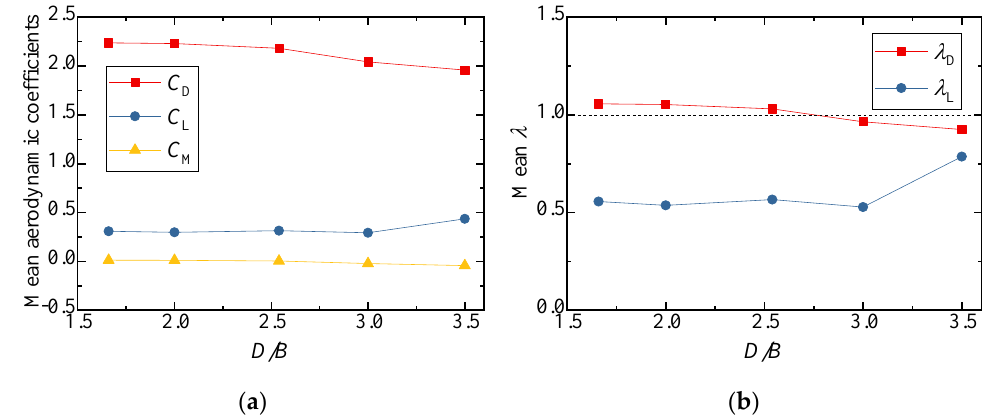
Figure 8. Comparison of the vehicle’s ( a ) aerodynamic coefficients and ( b ) interference factor for various D/B ratios in Case 2.